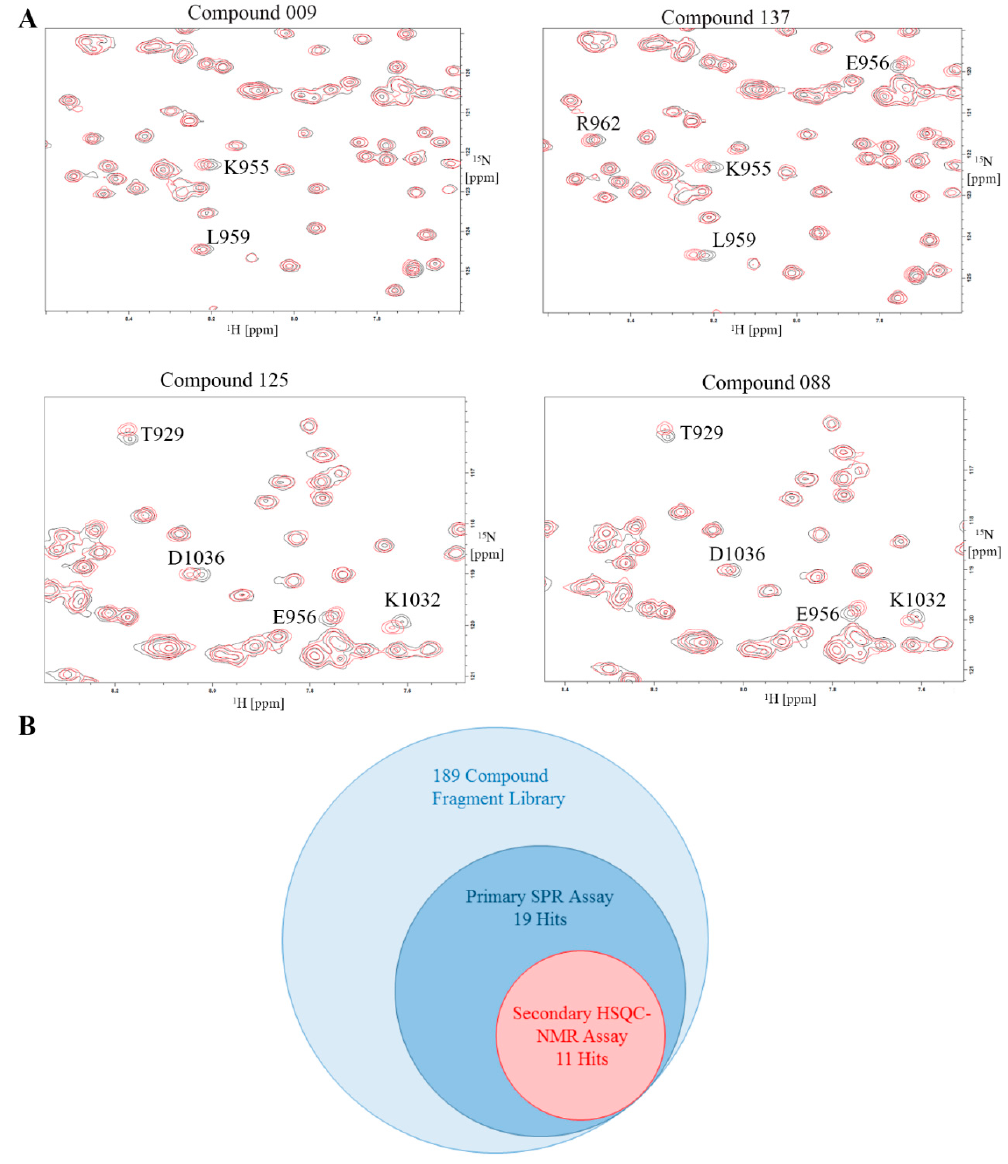
Figure 6. Validation of hits from SPR utilizing 2D HSQC-NMR. ( A ) Representative HSQC overlays displaying the CSPs of four hits. Compounds 009 and 137 demonstrate multiple CSPs in the helix 2-3 binding site. Compounds 125 and 088 demonstrate a mix of helix 2-3 and 1-4 binding. ( B ) Venn diagram detailing the number of hits after each screen. The initial library was 189 compounds, with 19 curated hits after SPR, and a final 11 hits after secondary screening by 2D HSQC-NMR.